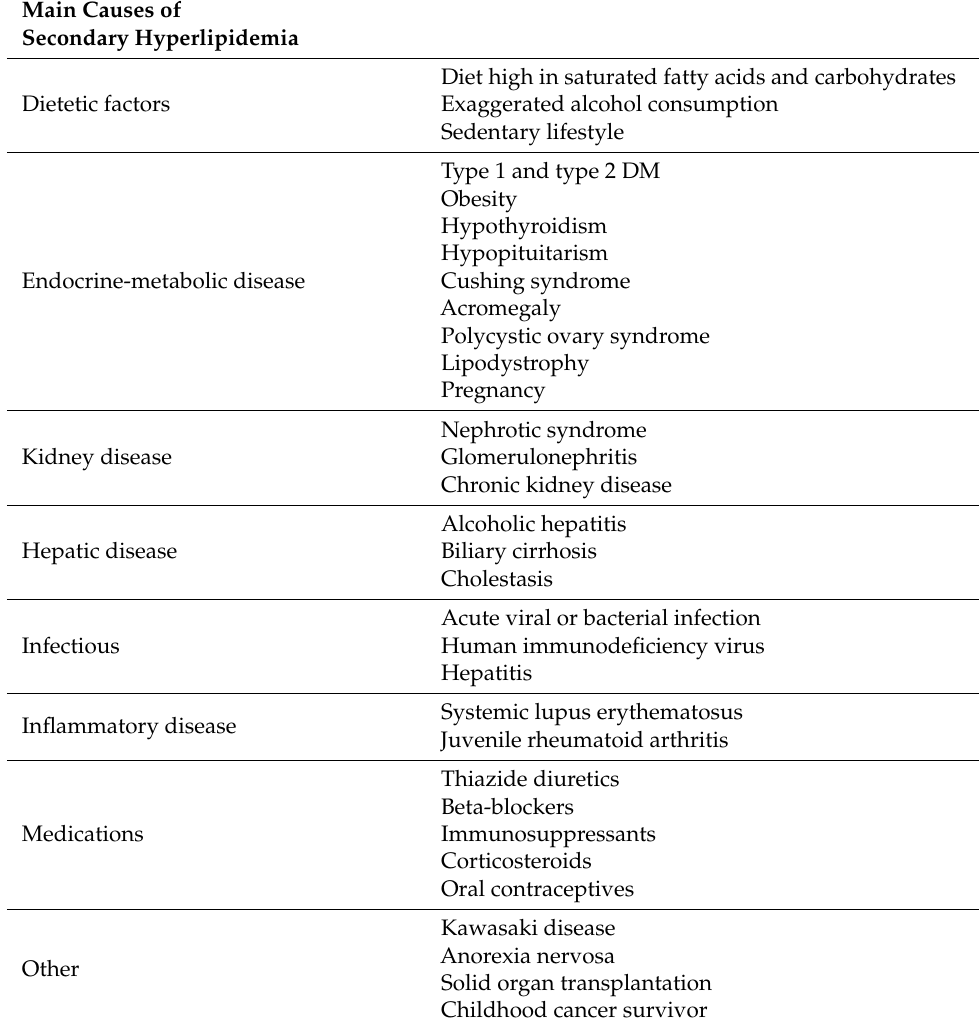
Table 2. Major causes of secondary